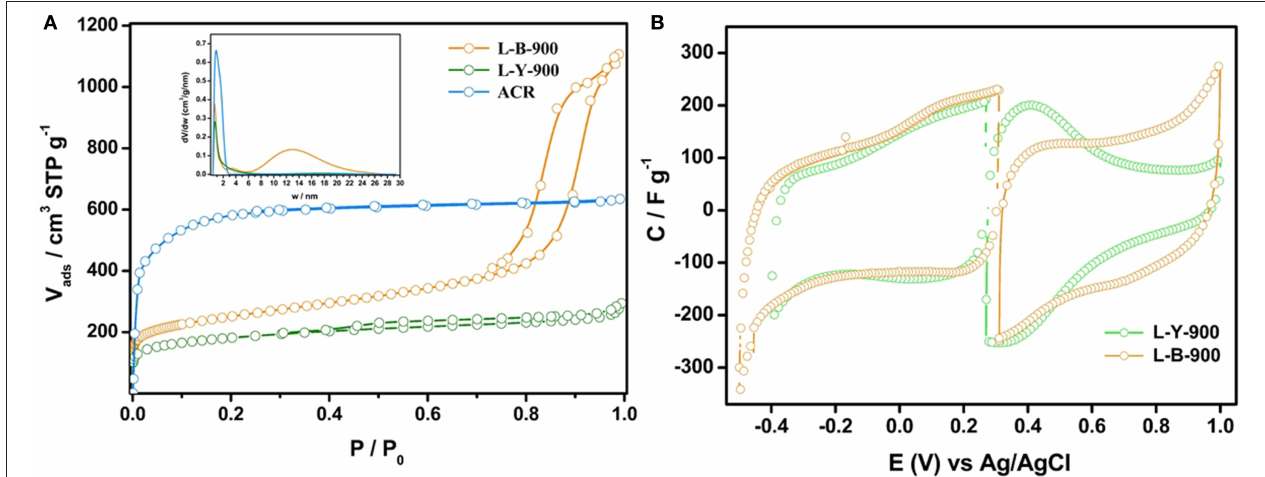
FIGURE 6 | (A) N 2 adsorption-desorption isotherms for all samples (The inset depicts their PSD). (B) Steady voltammograms from for both lignin-based HPCs.